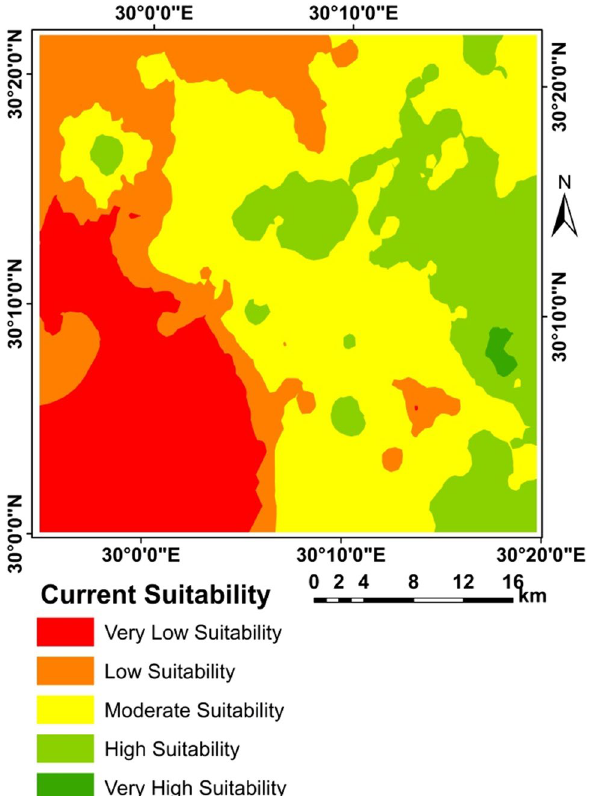
Figure 7. Current suitability based of FAO.